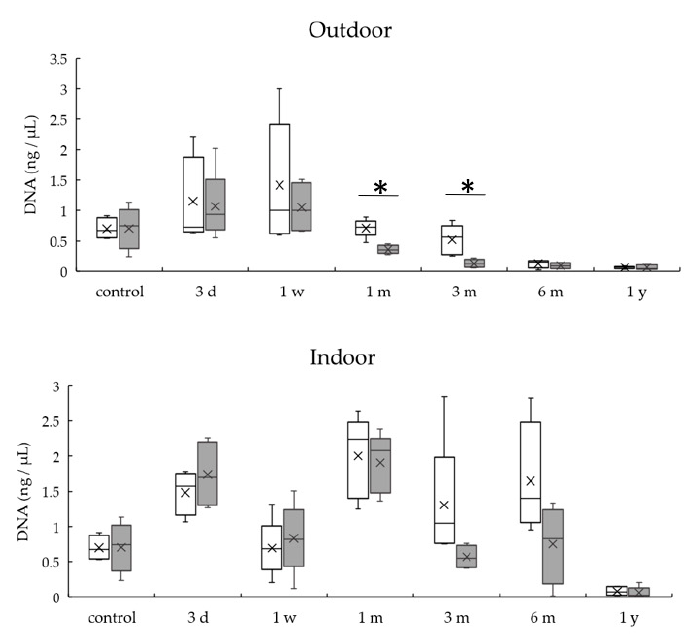
Figure 4. DNA degradation over time based on the amplification of 404 bp and 128 bp fragments by real-time PCR (404 bp vs. 128 bp). * p < 0.05, ** p < 0.01.